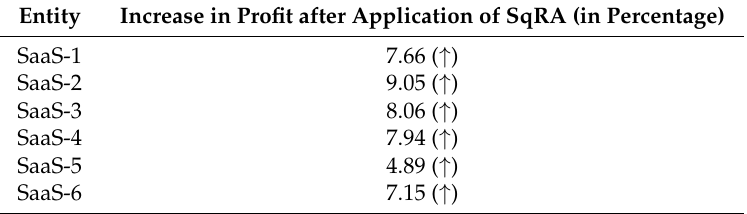
Table 4. Increase in profit earned by the Softaware-as-a-Service (SaaS) providers after implementing